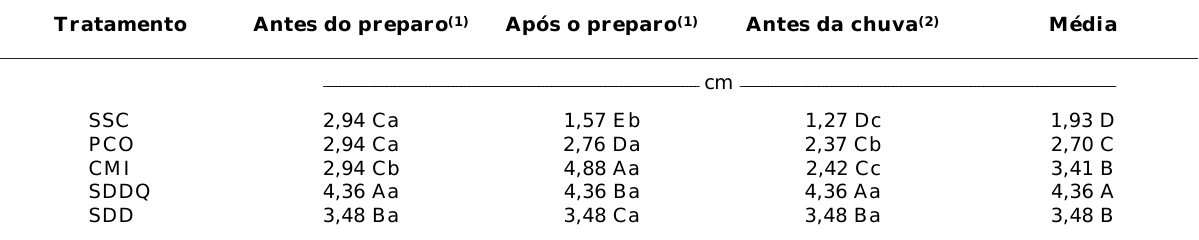
Quadro 2. Rugosidade do solo imediatamente antes e depois do preparo e imediatamente antes do primeiro teste de chuva simulada, sobre um Nitossolo Háplico